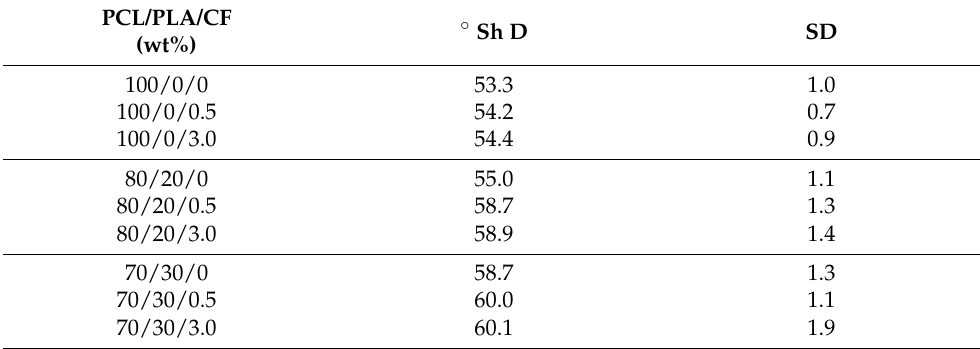
Table 4. Hardness of PCL/PCL/CF blends.